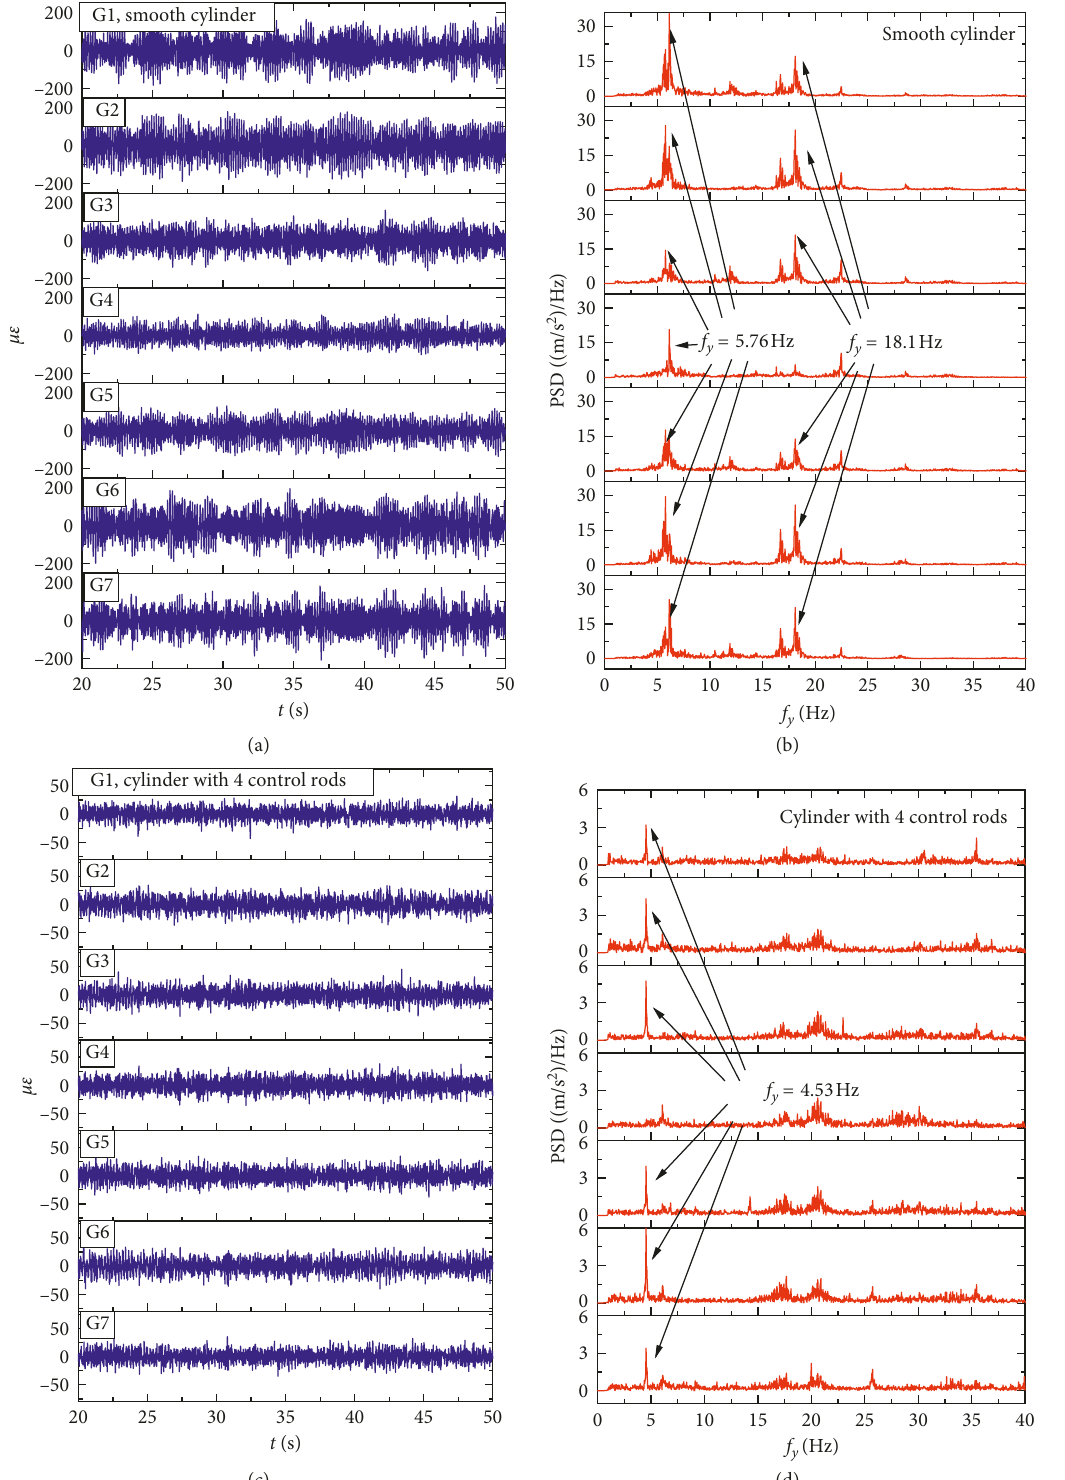
Figure 9: Strain response characteristic of the inclined flexible cylinder ( α shedding at U 0.85 m/s (the first column presents time history of strain signals ((a), (c)) and the second column presents response (cid:31) spectra ((b),